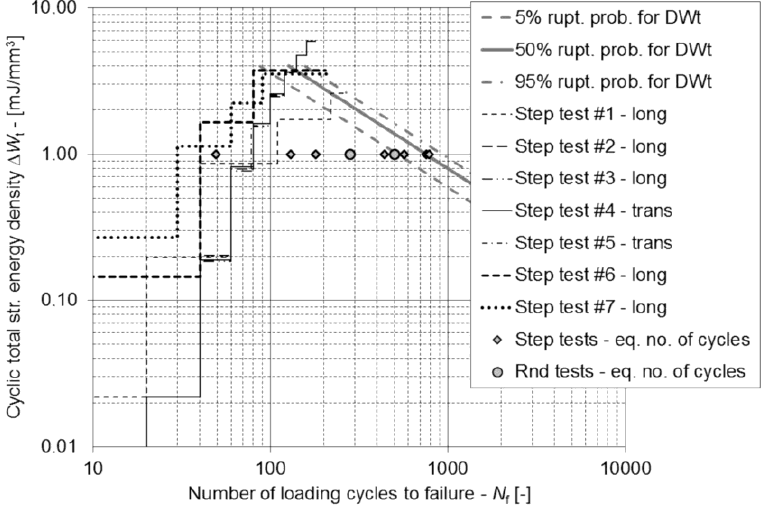
Figure 12. Fatigue-life curves with the variable-amplitude loading results for the total strain-energy density ∆ W t (DWt); ∆ W t,eq = 1 mJ / mm 3 .